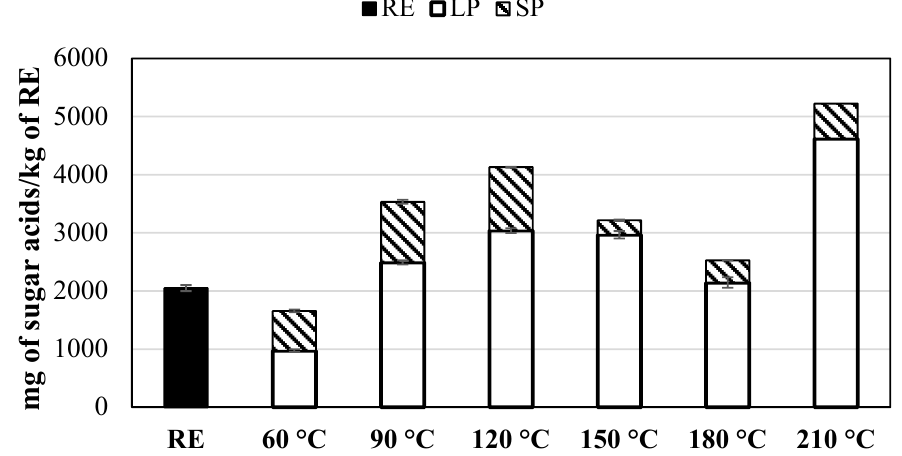
Figure 2. Sugar acids expressed as grams of galacturonic acid per kilogram of extrudate for untreated RE and different fractions obtained after the hydrothermal treatments.